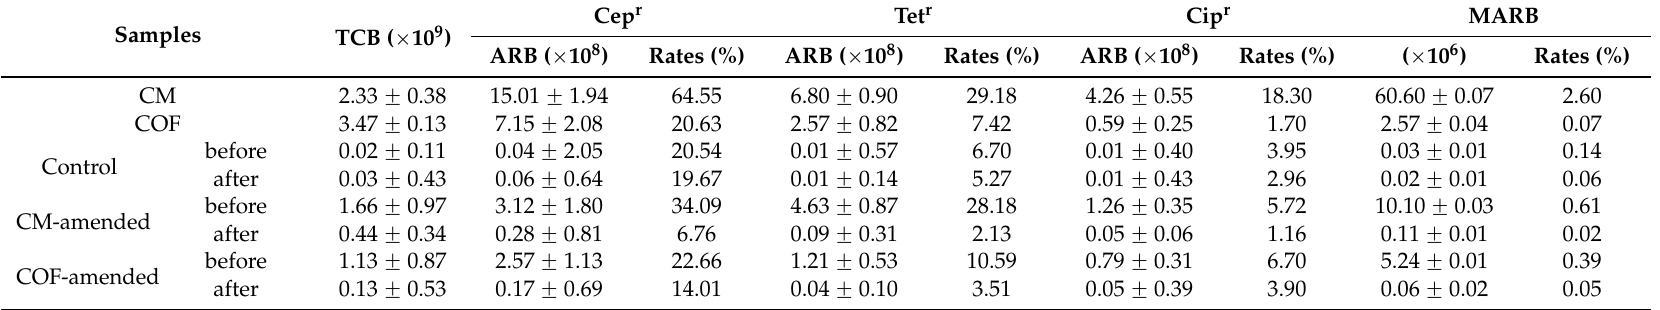
Table 1. Concentrations and rates of ARB and MARB in different treatment soils before and after growing pakchoi (CFU ¨ g ´ 1 ).